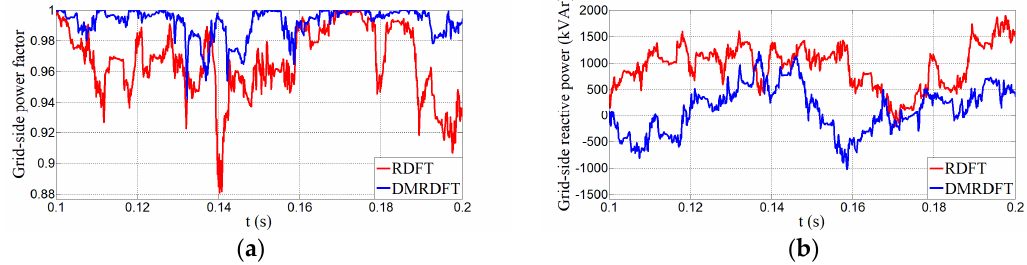
Figure 12. Contrast of the SAPF reactive power control performance: ( a ) grid-side power factor, and ( b ) grid-side residual reactive power.